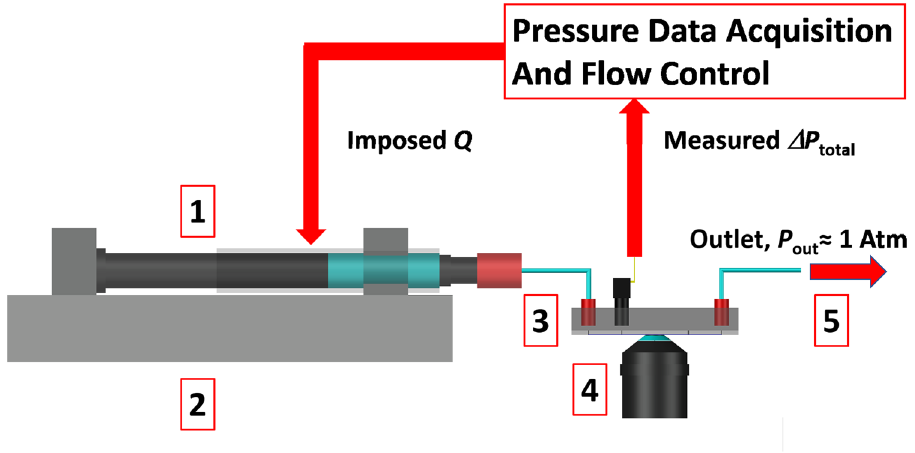
Fig. 3 Schematic diagram of a typical “syringe-on-chip” experimental setup. The LabVIEW-based data acquisi- tion platform allows to impose a flow rate Q to the syringe pump, and to measure the total pressure drop 𝛥 P total from the pressure sensor. 1 Sample- filled glass syringe. 2 Syringe pump. 3 “Syringe-on-chip” microdevice. 4 Magnification lens. 5 Outlet